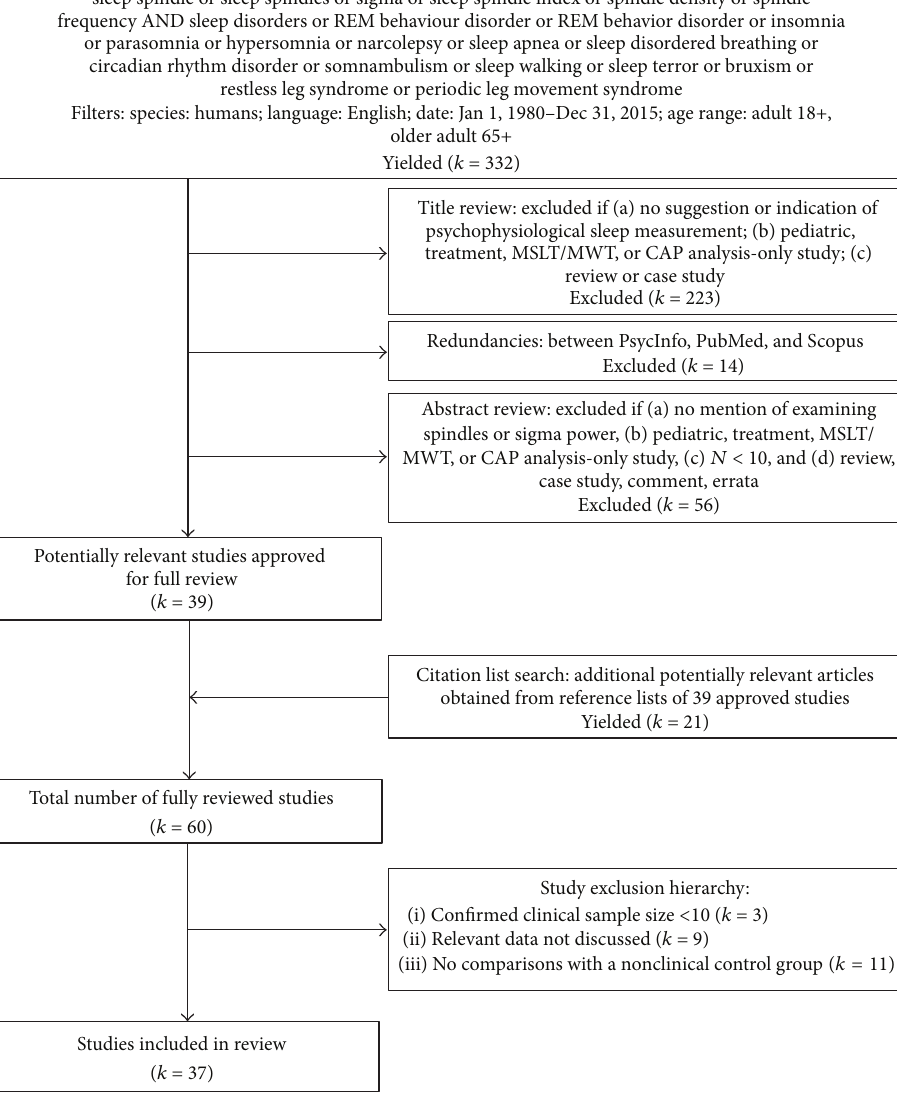
Figure 1: Flow chart for article identification and